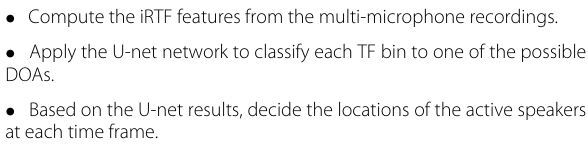
Table 1 The TF-DOAnet multi-speaker localization